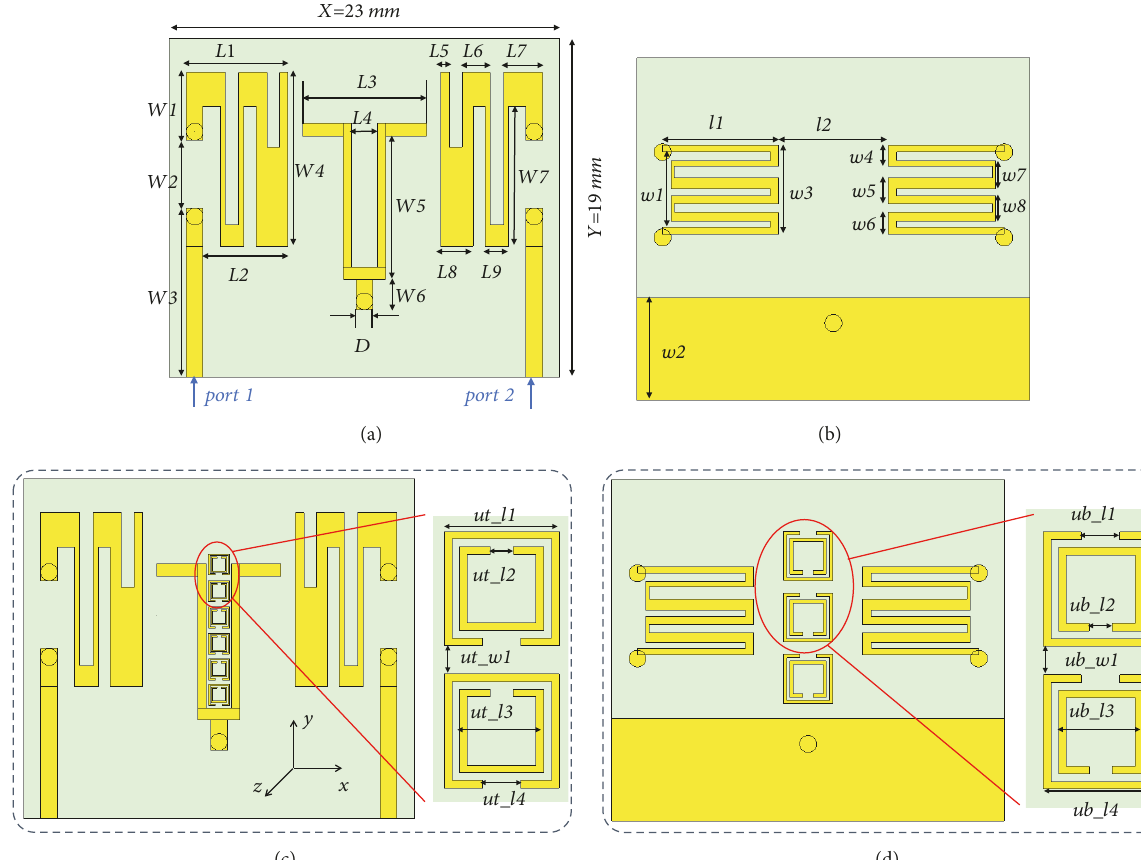
Figure 1: (a) The top of the antenna without SRRs. (b) The bottom of the antenna without SRRs. (c) The top of the antenna with SRRs. (d) The bottom of the antenna with